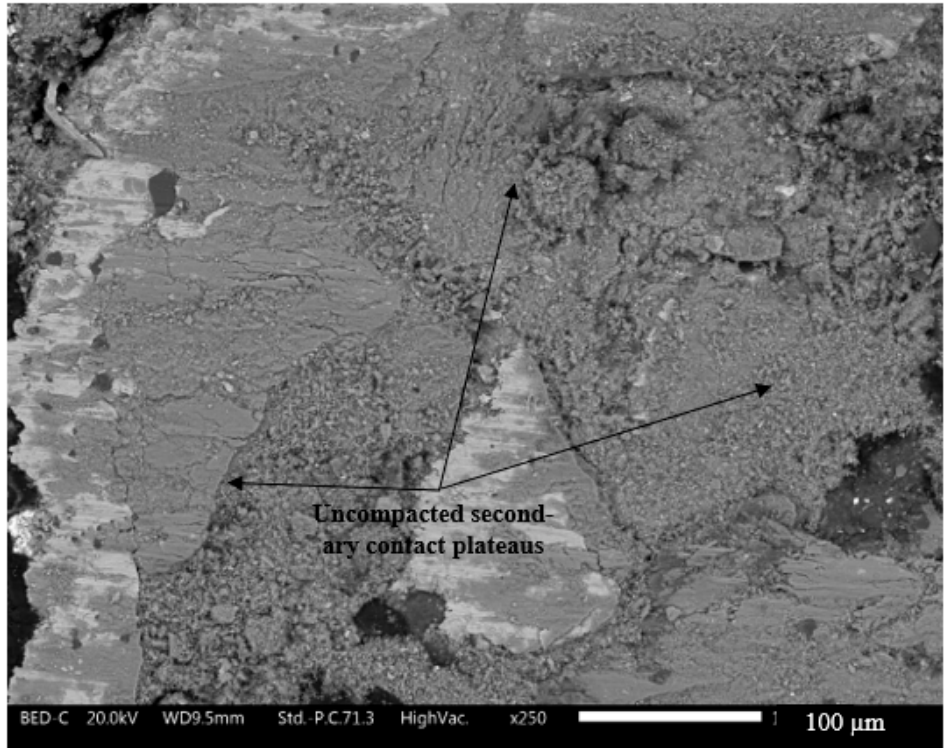
Figure 15. High magnification of the worn CFM with 20 PP pin surface image. The uncompacted secondary contact plateaus are marked in the Figure.